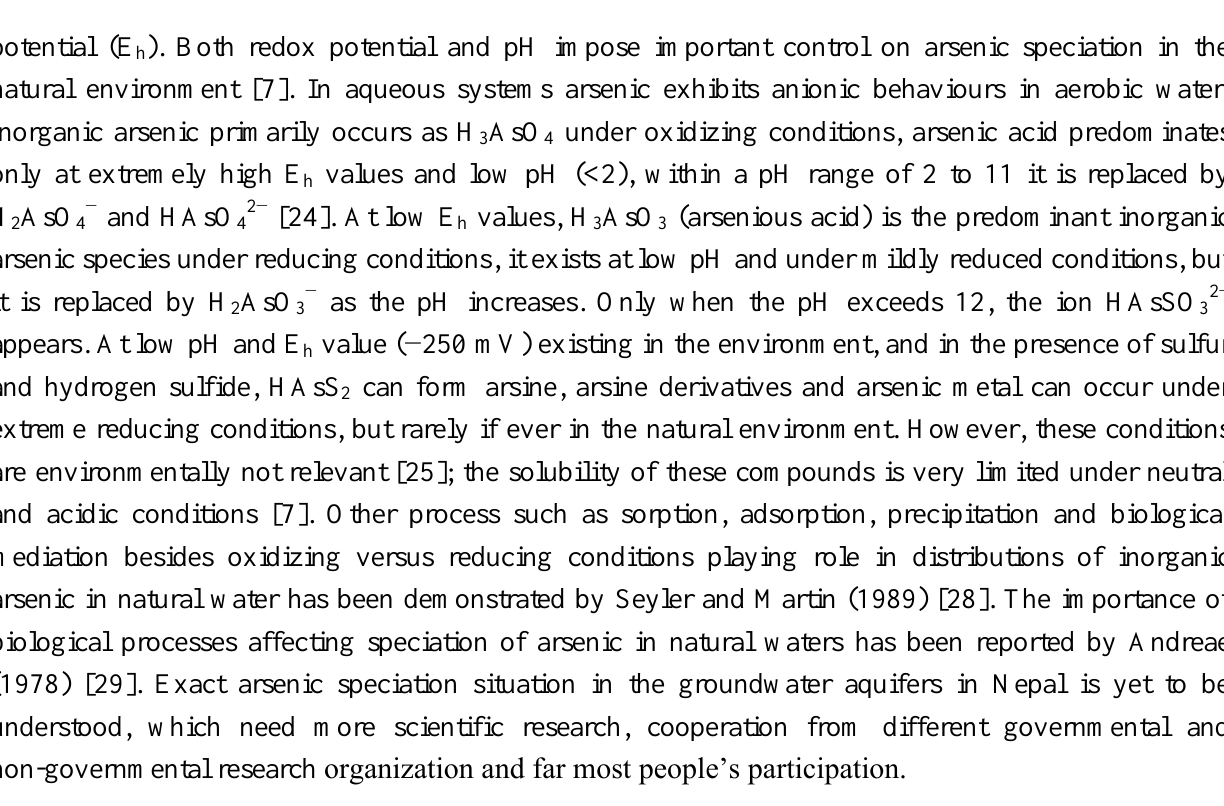
Table 1. Major arsenic compounds of environmental and clinical interest (modified from Sharma (2009)